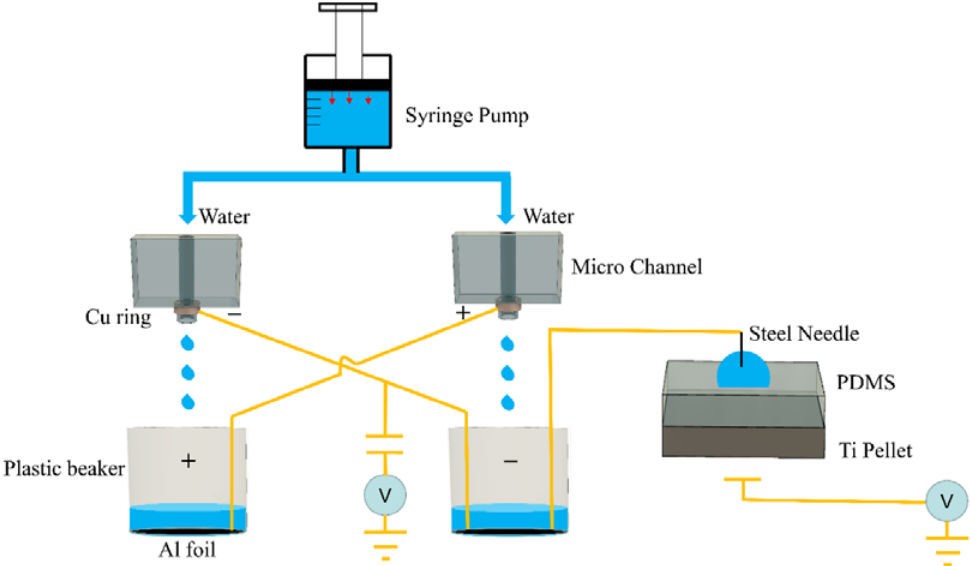
Figure 1. Schematic diagram of the electrowetting system using the microfluidic Kelvin water dropper (MKWD).